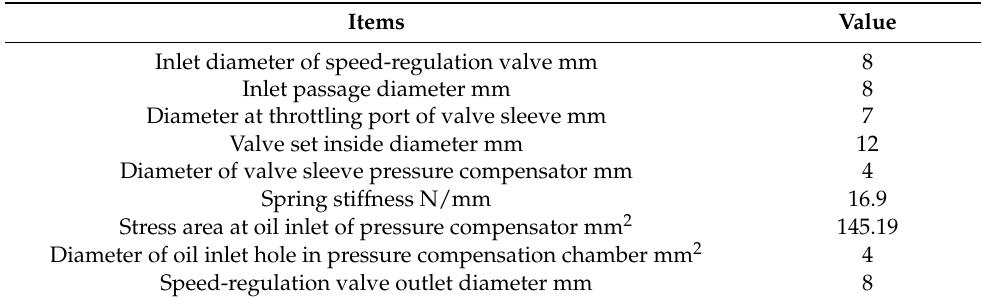
Table 1. Parameters of the governor valve.